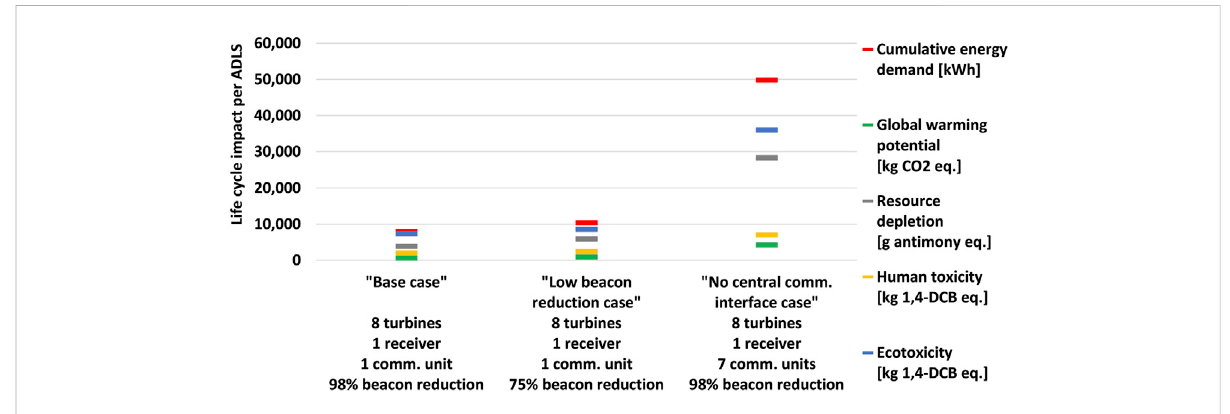
FIGURE 6 LCIA for different ADLS cases. Functional unit: one